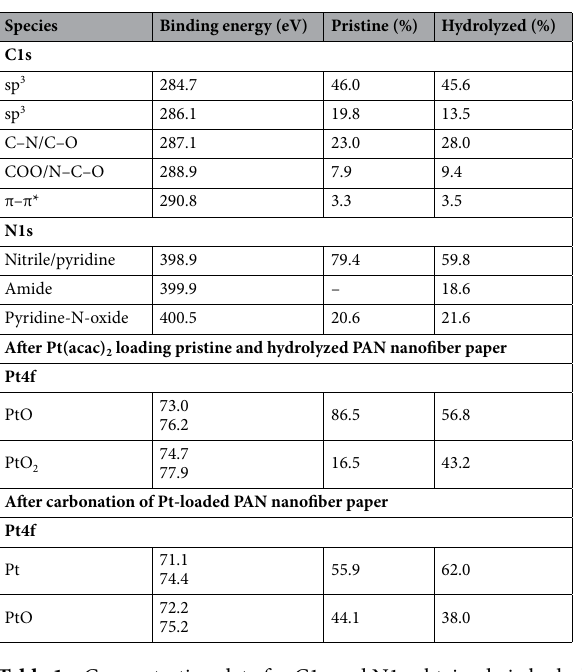
Table 1. Concentration data for C1s and N1s obtained via hydrolysis, and the change in Pt4f. after carbonisation obtained through XPS analysis.